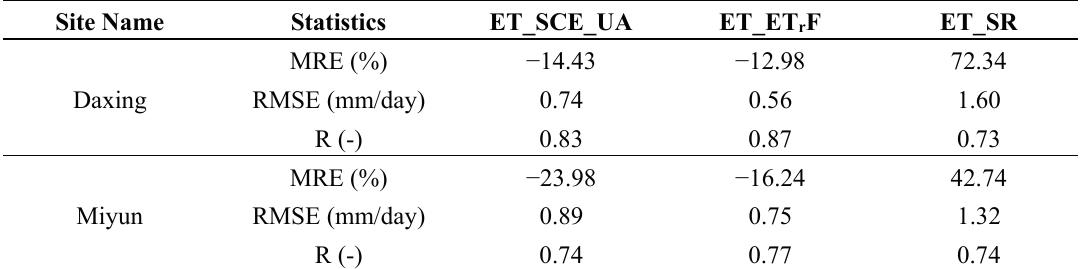
Figure 8. The comparisons of cloudy-day ET between model estimates and in situ observations. (Daxing site result ( top row); Miyun site result ( bottom row)). Table 6. The statistics of temporal reconstruction approaches at the Daxing and Miyun